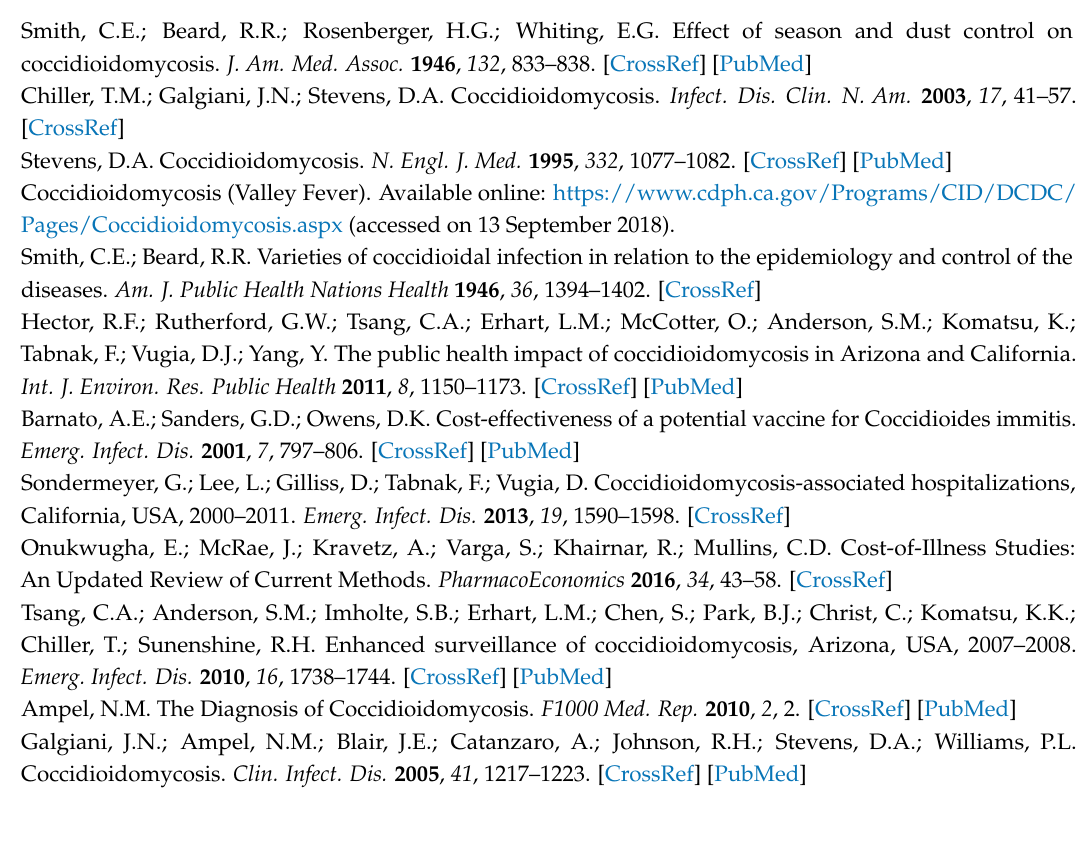
s1: Figure S1: Physician interview guide and treatment